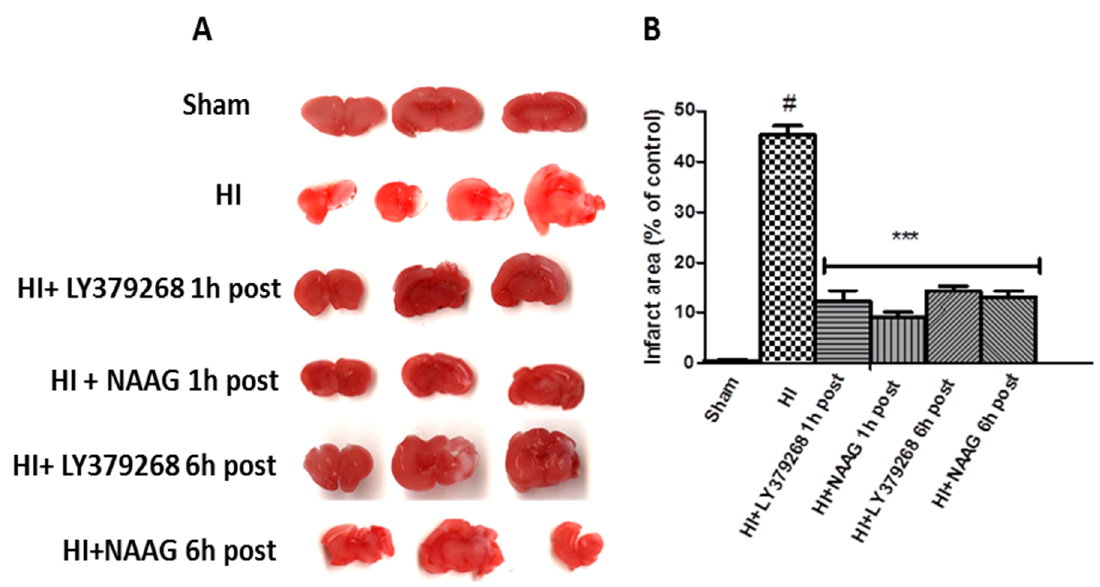
Figure 1. ( A ) Application of LY379268 or NAAG after hypoxia-ischemia (HI) reduces the infarct area in the ipsilateral hemisphere. Representative pictures of TTC staining of the infarct areas in the brains of rats; ( B ) Quantification of the infarct area after HI revealed by TTC staining. The number of animals per group n = 4–5. Results are presented as the mean values ± SD, *** p < 0.001—significantly different from the HI group; #—significantly different from the sham. The brains were analyzed 7 days after HI.